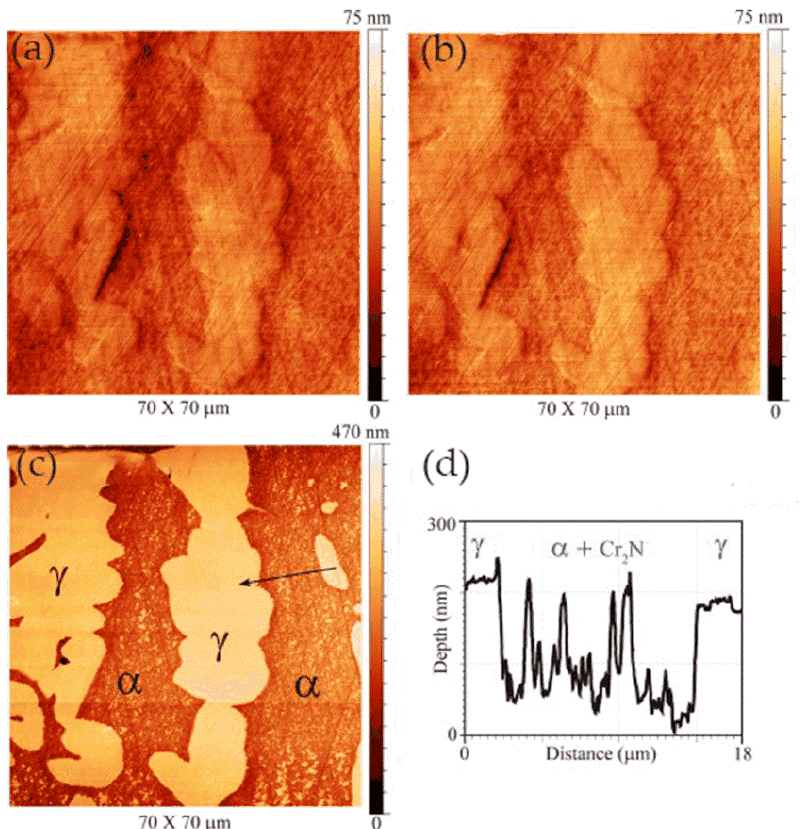
Figure 20. In situ EC-AFM images of the same area of the 2205 HT in 1 M NaCl at room temperature under electrochemical control at different applied potentials: ( a ) OCP, ( b ) 1.1 V Ag/AgCl , and ( c ) 1.2 V Ag/AgCl . ( d ) Depth line profile from the arrow in image ( c ) showing particles or particle clusters remaining in the dissolved ferrite area. Reprinted with permission from Reference [55]; copyright 2013 Elsevier Ltd.